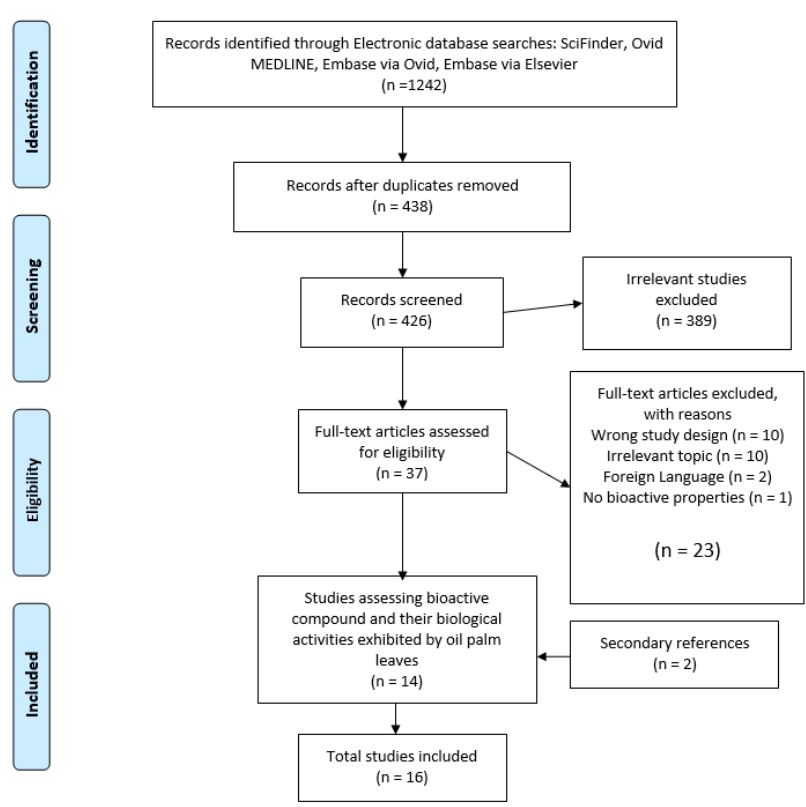
Figure 1. PRISMA flow diagram for article selection process. Table 2. Detection and identification of flavonoids in the leaves of E. guineensis and their TPC and TFC values. Methods for Detecting and Reference